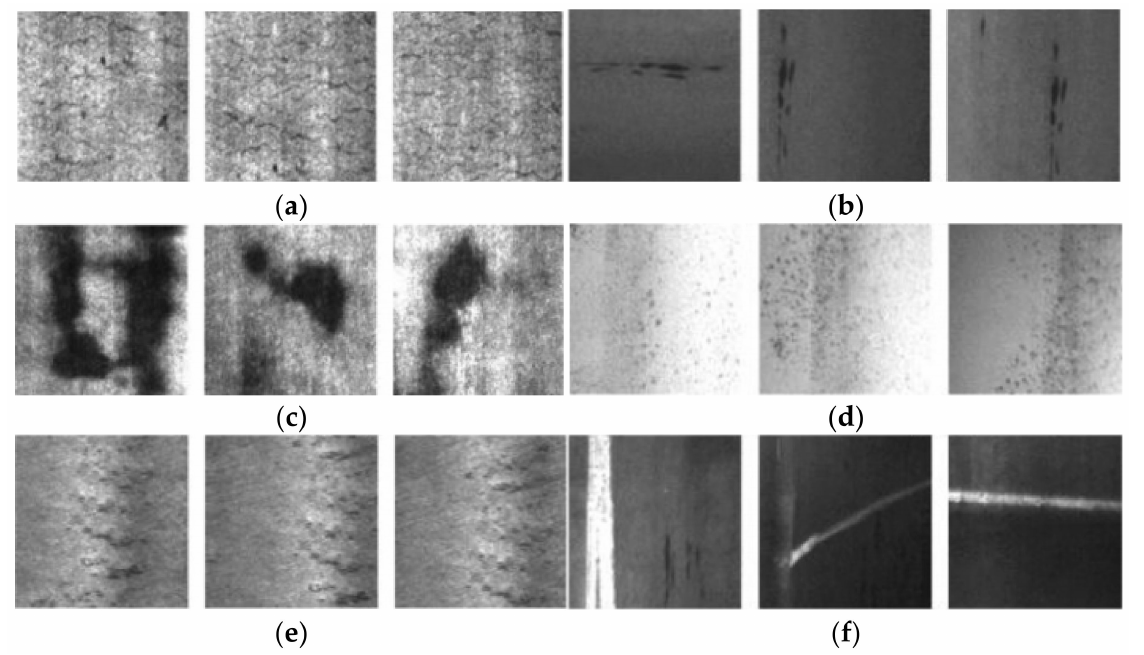
Figure 2. Examples of defect images in NEU: ( a ) crazing (Cr), ( b ) inclusion (In), ( c ) patches (Pa), ( d ) pitted surface (PS), ( e ) rolled-in scale (RS), and ( f ) scratches